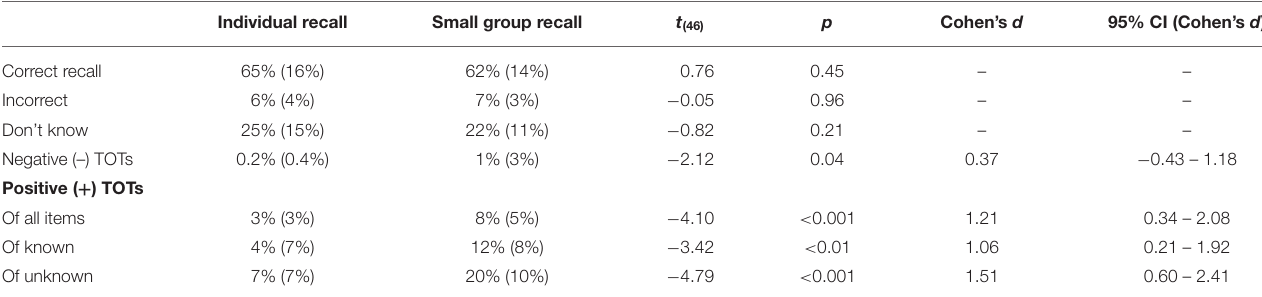
TABLE 1 | Mean (standard deviation) percentages of correctly recalled items, incorrect and “Don’t Know” responses, negative and positive TOT indexes, by recall condition (all